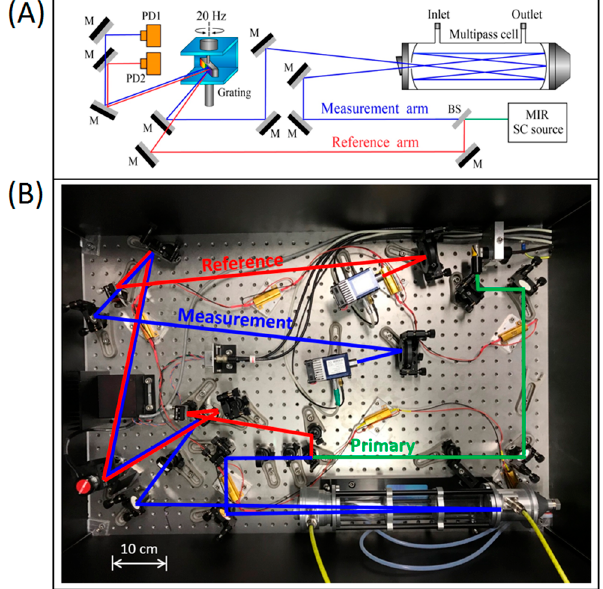
Figure 2. ( A ) Simplified schematic representation of the optical setup (M: mirror, BS: beam splitter, PD: photodetector). ( B ) Top view of the optical system. Note that the primary SC beam (highlighted in green) is split into the measurement (blue) and reference (red) beams.